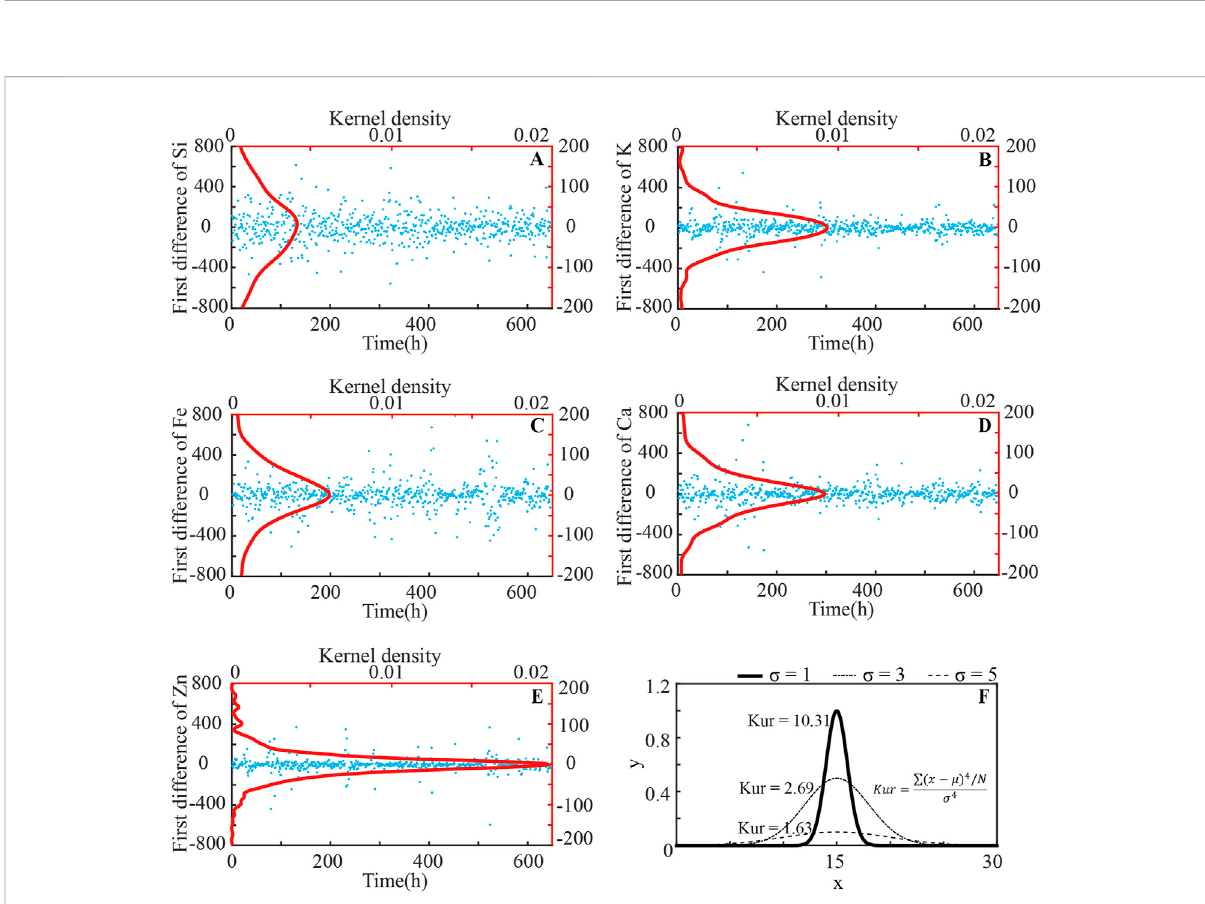
FIGURE 9 First-order difference of suspended particulate matters ’ concentration and their kernel density curves. (A – E) are the fi rst difference of Si, K, Fe, Ca, and Zn, respectively; (F) shows the de fi nition of